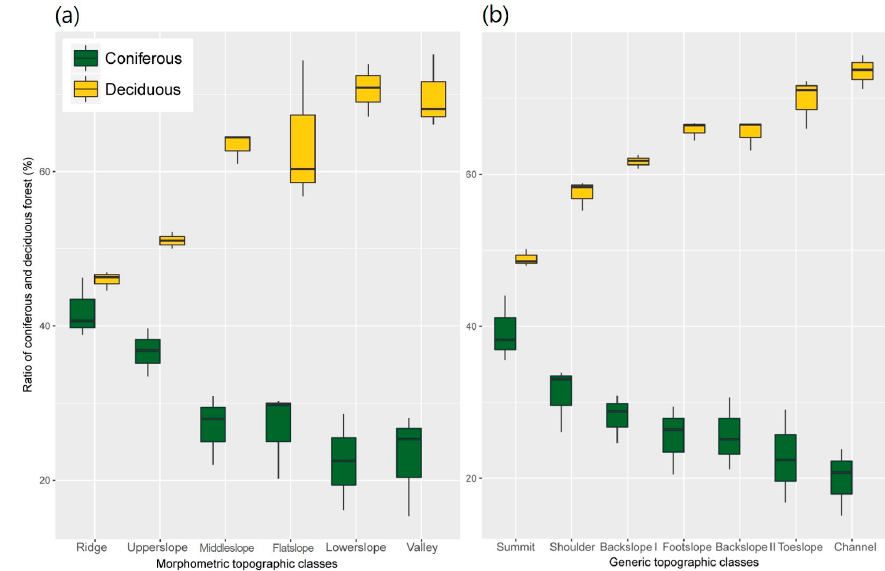
Figure 5. Ratio of coniferous and deciduous forests in morphometric ( a ) and generic ( b ) topographic classes. The ratios of coniferous and deciduous forests in the generic topographic classification showed a similar trend with the habitat preference of these types of vegetation. However, in the morphometric topographic classification, from Flatslope to Valley, representing low slope and concave surface, the ratios had different trends than the coniferous ecological characteristics.